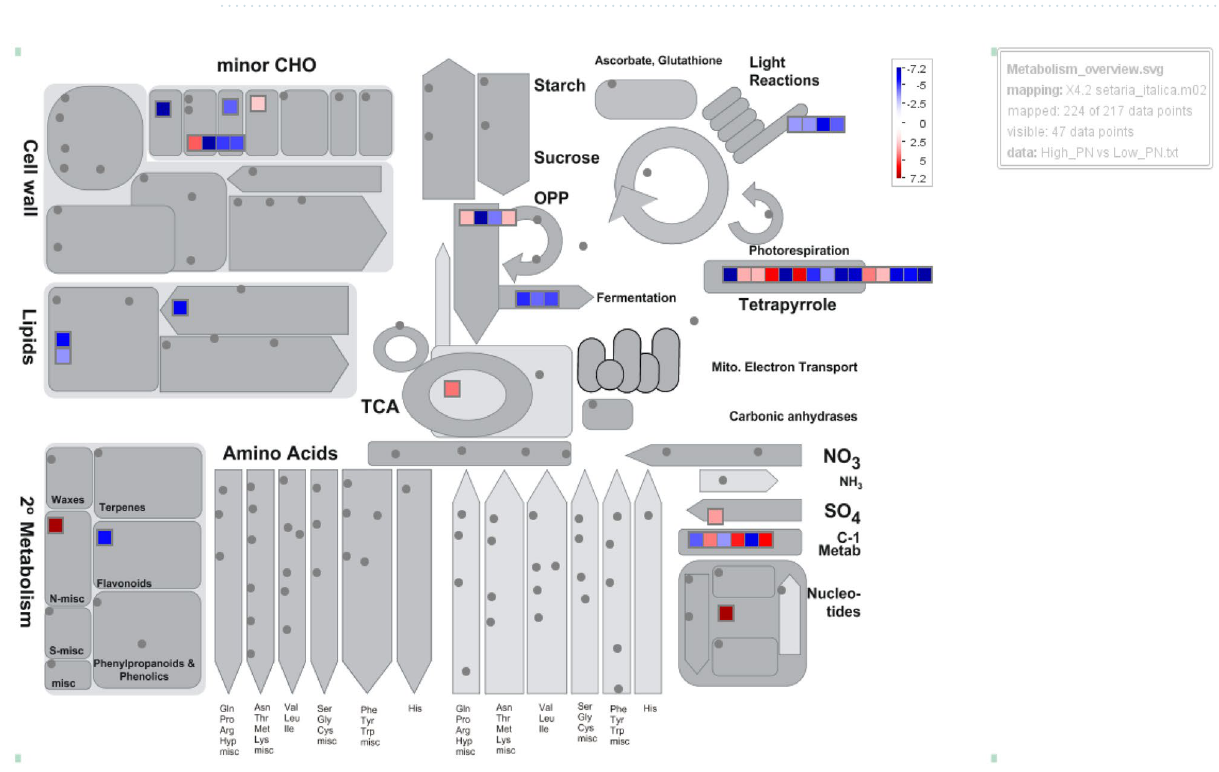
Figure 5. A representation of transcript abundance from the high Fe genotype milking stage versus low Fe genotype milking stage experiment displaying differential gene expression involved in metabolism. (The logarithmic colour scale bar ranges from − 7.2 to + 7.2 (dark red, representing a threefold up ‐ regulated